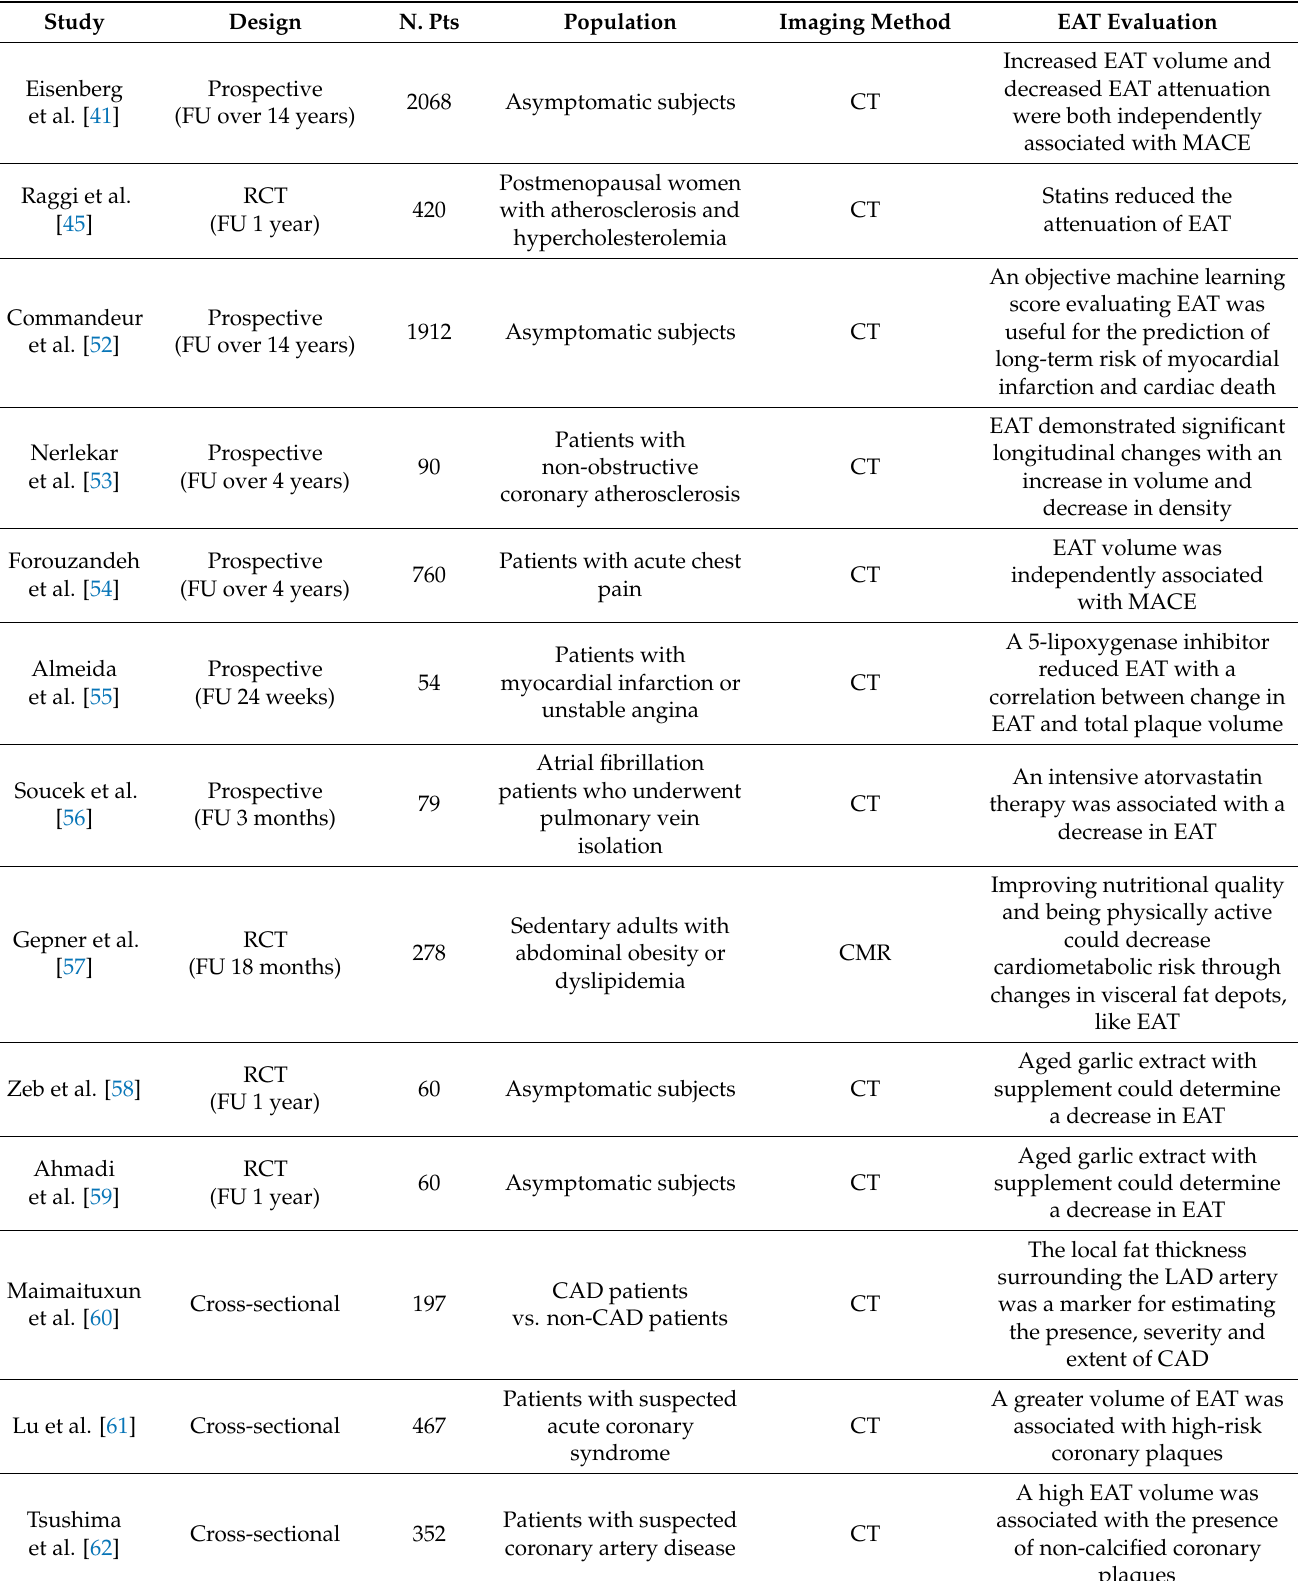
Table 1. Epicardial adipose tissue evaluation in cardiovascular